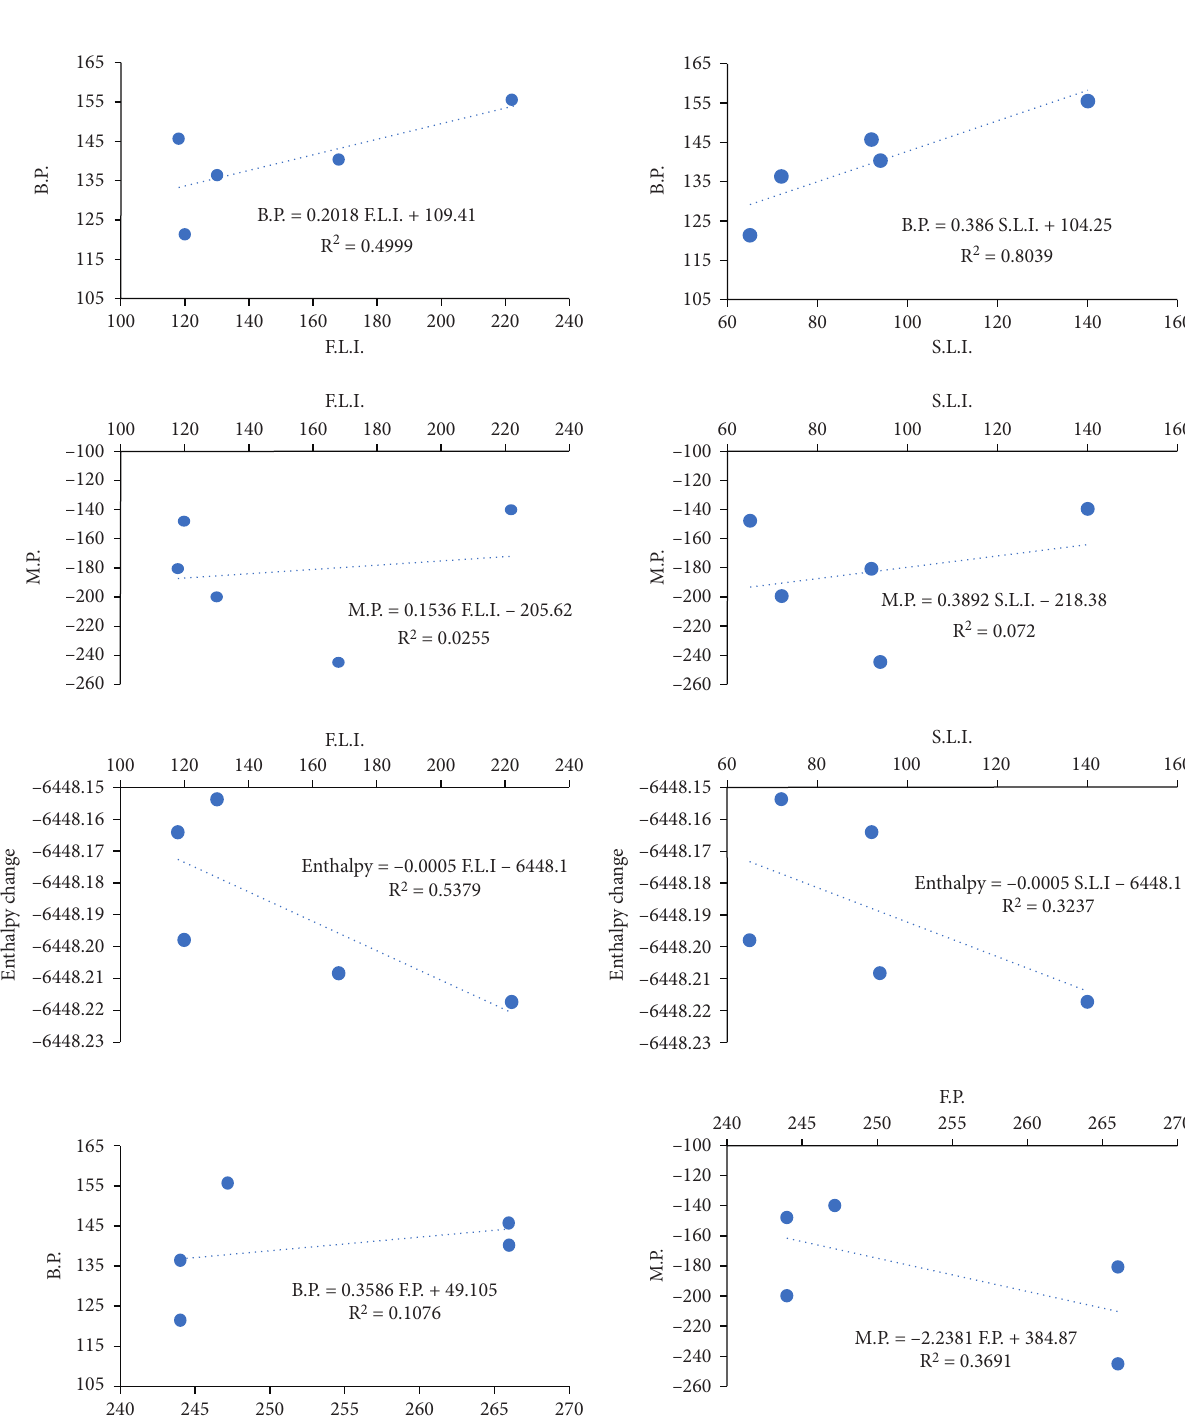
Figure 5: Graphical relationships between the boiling points (B.P.), melting points (M.P.), flash points (F.P.), enthalpy change (E.G.), and the calculated topological indices of hexane and its four isomers, where R2 represents the correlation